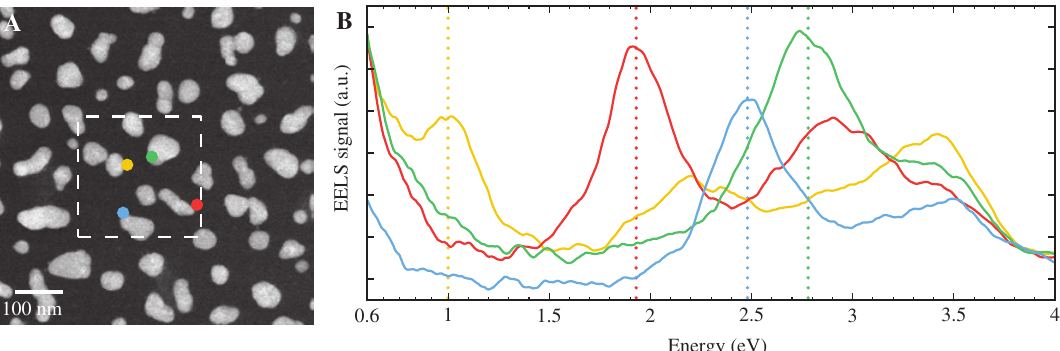
Figure 5: (A) STEM image of silver NPs deposited by electroless plating on a TEM-suitable 20-nm-thick silicon nitride membrane, showing some of the characteristic particle shapes and sizes. EELS has been collected in the area enclosed by the white dashed box. (B) EELS spectra from specific positions indicated by the colored dots. The vertical dotted lines highlight the lowest-energy resonance for each of the differ- ent